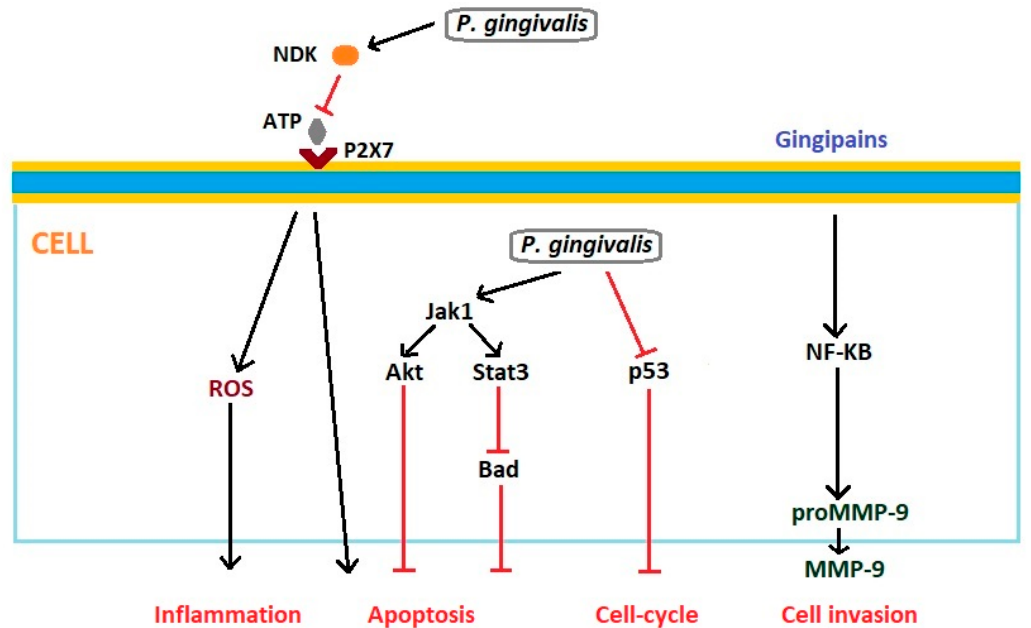
Figure 2. Interactions between Porphyromonas gingivalis and epithelial cells that can affect development of oncogenic phenotype. Based on Gholizadeh et al. [58] and Whitmore and Lamont [61]. Akt: protein kinase B; ATP: Adenosine triphosphate; Bad: Bcl-2-associated death promoter; Jak1: Janus kinase 1; MMP: metalloproteinase; NDK: nucleoside diphosphate kinase; NF-kB: nuclear factor kappa B; P2X7: Purinergic receptor; p53: Tumor protein p53; ROS: reactive oxygen species; Stat3: Signal transducer and activator of transcription 3.